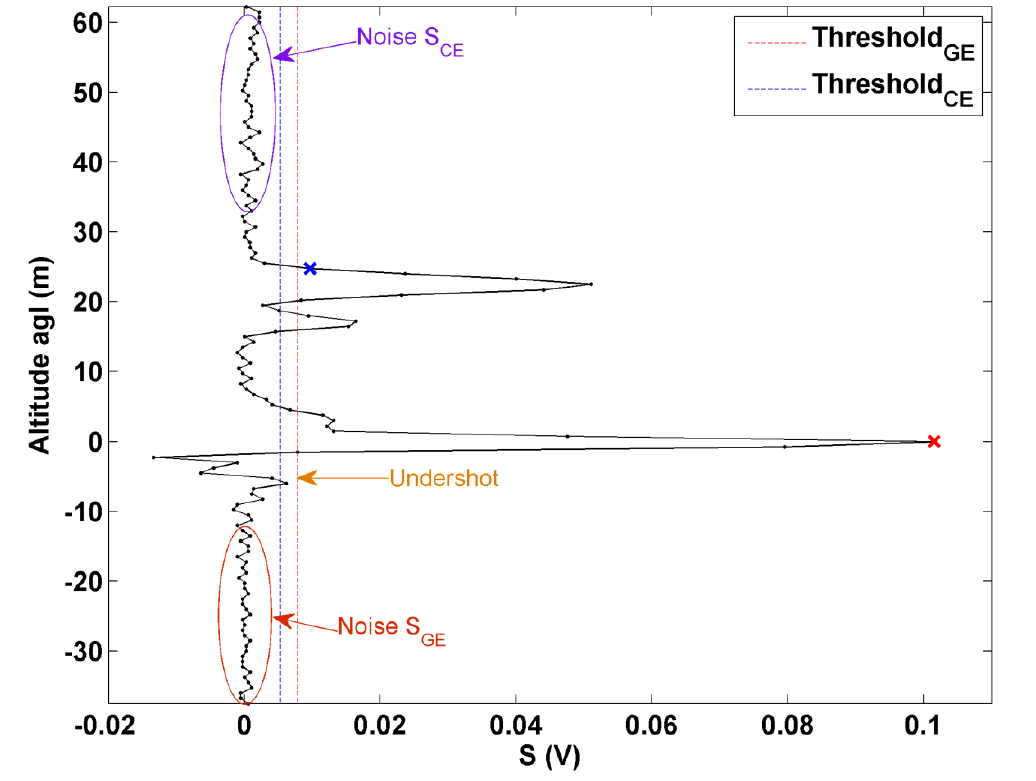
Figure 4. Typical example of a lidar profile measured over a sampling site. The two thresholds used to detect the ground echo (GE) and the canopy echo (CE) are represented in red and blue,